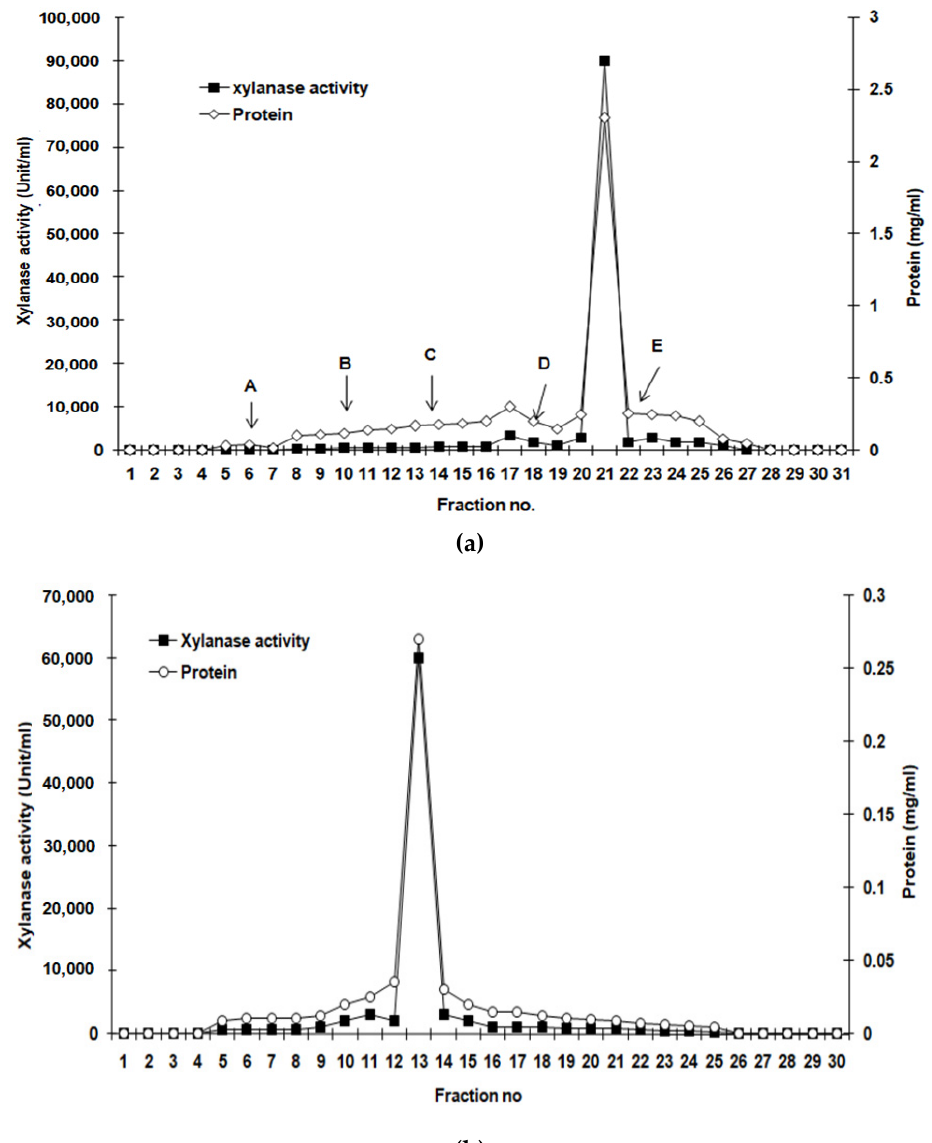
Figure 1. ( a ) Purification profile of extracellular xylanase from Bacillus paramycoides T4 on an anion- exchange column (Q-Sepharose) equilibrated with sodium phosphate buffer (100 mM, pH 7.0). The xylanase was eluted with a gradient of sodium chloride (0.1 M–0.5 M) in sodium phosphate buffer (100 mM, pH 7.0). A—0.1 M, B—0.2 M, C—0.3 M, D—0.4 M, and E—0.5 M. ( b ) Further purification of active fraction from ion exchange chromatography xylanase purification profile using Sephadex G-75 gel filtration chromatography. Sodium phosphate buffer was used to equilibrate the column (100mM, pH 7.0). The same buffer was used to load and elute the